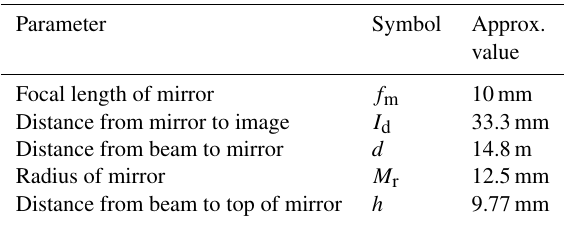
Table A1. Parameters derived from information in Gao et al. (2016).